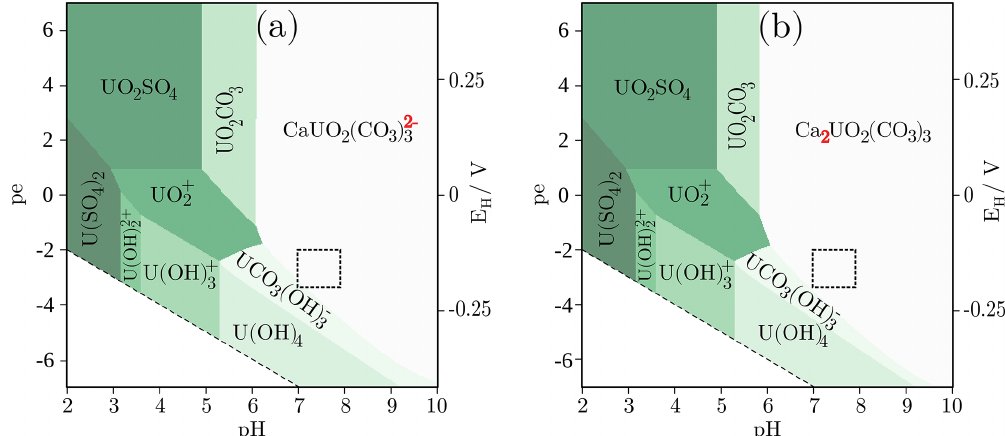
Figure 1. Pourbaix diagrams for the aqueous uranium speciation in the pore water of the shaly facies with an uranium background concentra- tion of 2.52µmol/L either using the logk = 29 . 22 given in the PSI/Nagra database (a) for the neutral, ternary uranyl complex or the value of 30.55 (b) obtained by Bernhard et al. (2001). The main change in speciation is highlighted by the red numbers. The pore water was initially equilibrated with the carbonates and pyrite for a p CO 2 of 10 − 2 . 2 bar and calculations were performed for standard pressure and temperature conditions (1bar, 25 ◦ C). The dashed box marks the pH and E H range measured in-situ in the Opalinus Clay